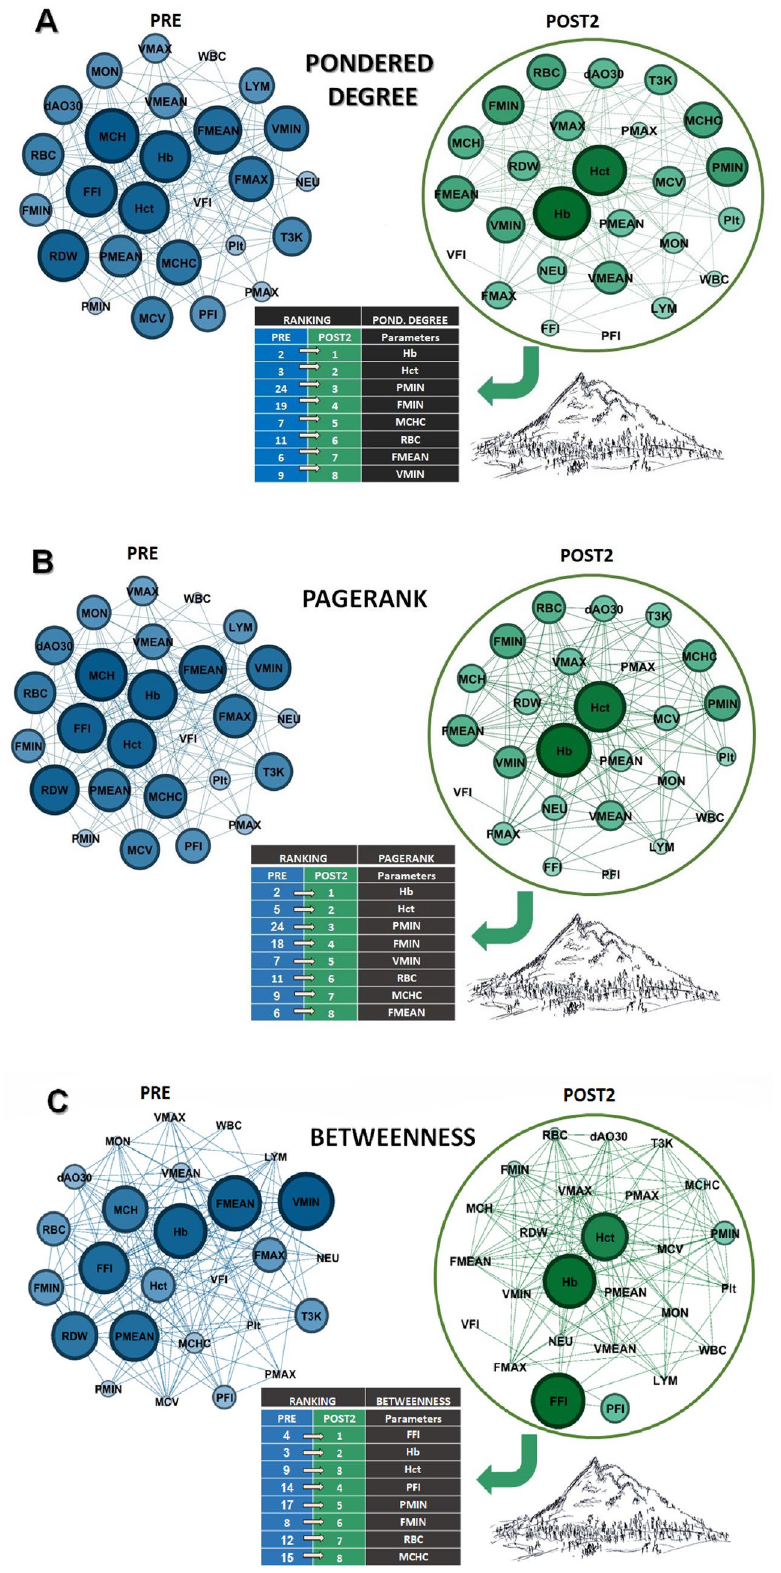
Figure 7. Centrality metrics in complex networks model. Panels ( A – C ) represent, respectively, the pondered degree , pagerank and betweenness graphs. The central table presents the positions of centrality for each metric in the two scenarios involved, being PRE immediately before the ascent to the altitude (2500 m) and POST2, 15 days after returning from